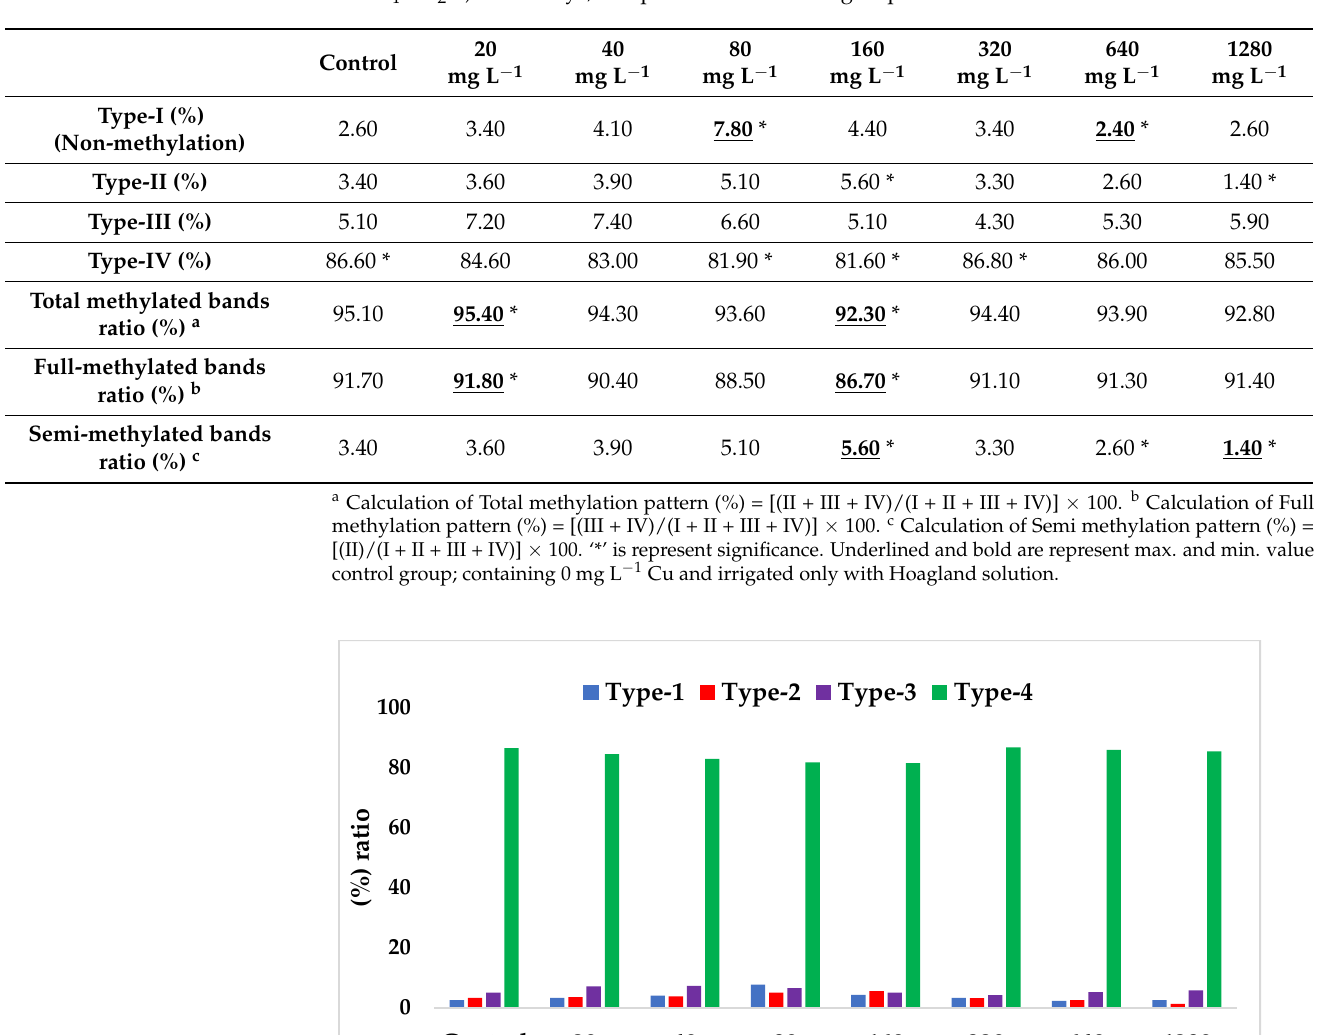
Table 4. The average rates of methylation types and patterns based on CRED-RA data analysis in the root tissues of safflower seedlings after exposure to increasing Cu concentrations (20–1280 mg L − 1 CuSO 4 · 5H 2 O) for 21 days, compared to the control group.